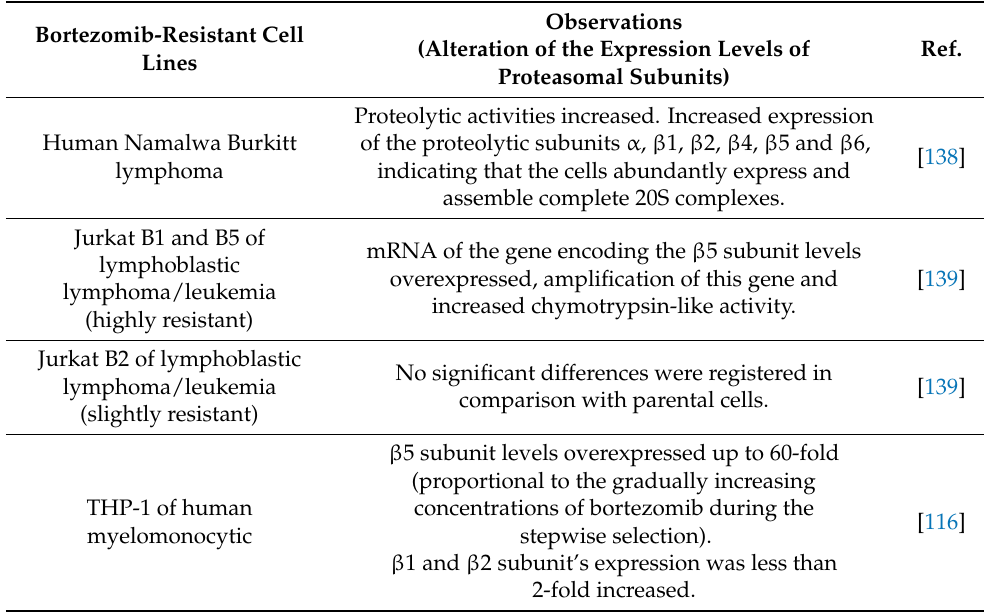
Table 1. Examples of studies of resistance to bortezomib (by continued exposure to inhibitor) mediated by 20S CP β 5 subunit